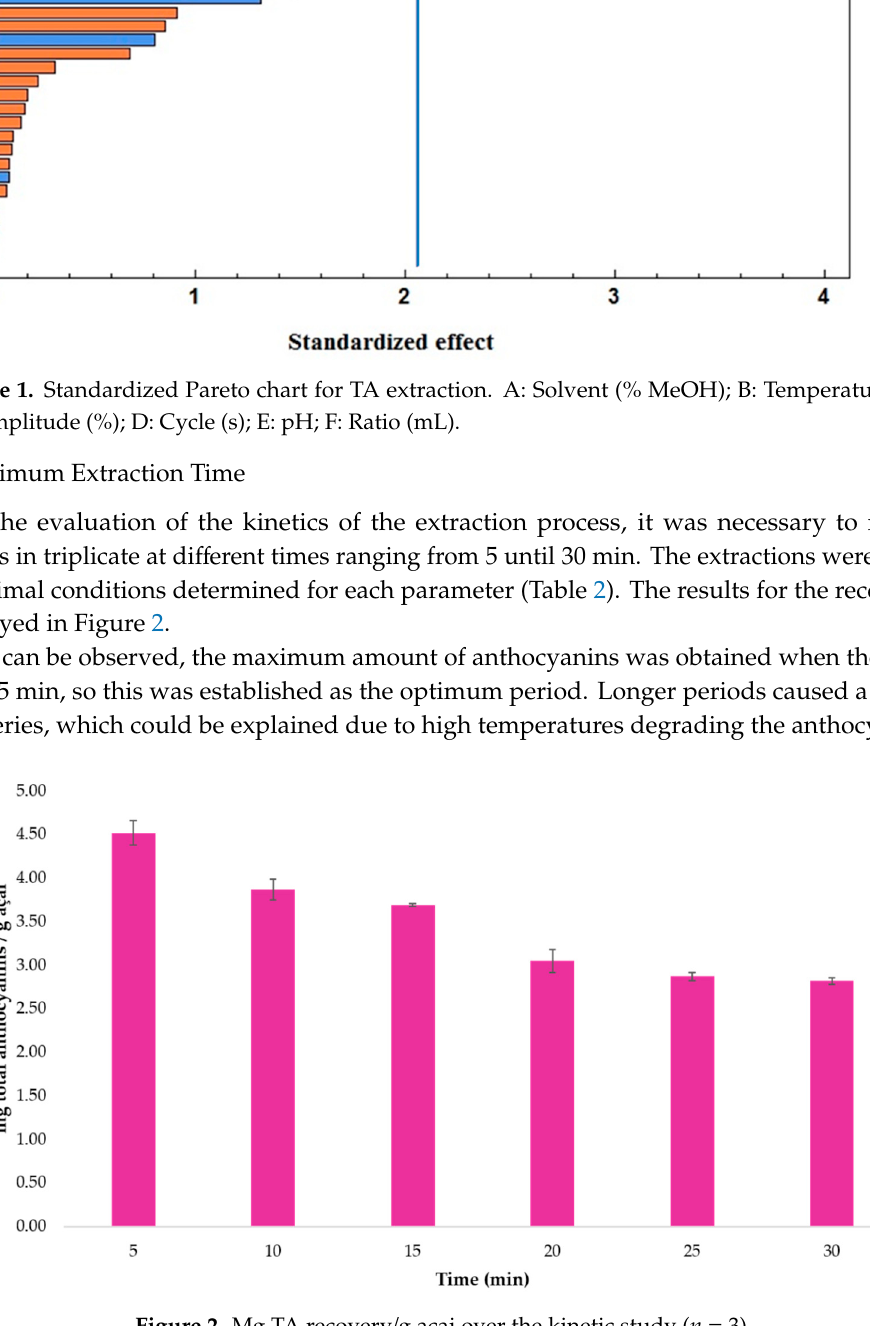
Figure 2. Mg TA recovery/g açai over the kinetic study ( n = 3).